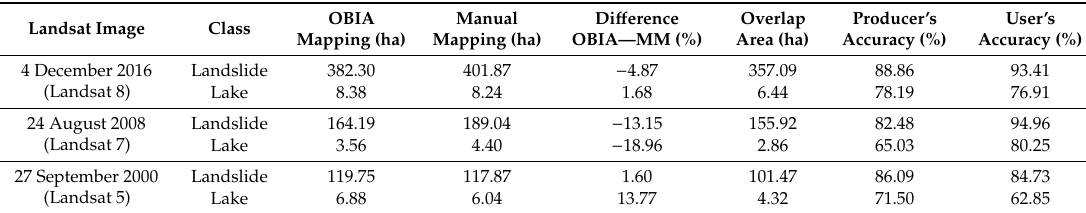
Table 5. OBIA and manual mapping (MM) results, the difference between OBIA and manual mapping results, overlapping area and producer’s and user’s accuracy for each of the three selected Landsat images.